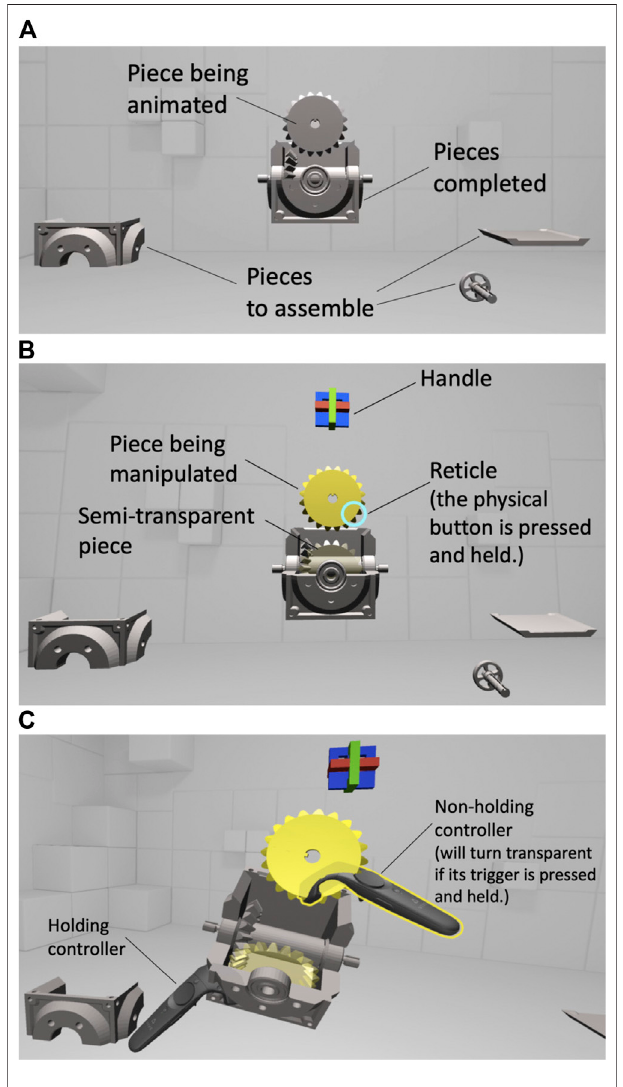
FIGURE 4 | (A) Video training: a participant passively watching a pre- recorded animation during the training, (B) Mobile VR training: a participant interacting with the virtual pieces using reticle at the center of the view and the magnet selection button on the cardboard, and (C) PC VR training: a participant interacting with the virtual gearbox via 3D tracked HTC Vive